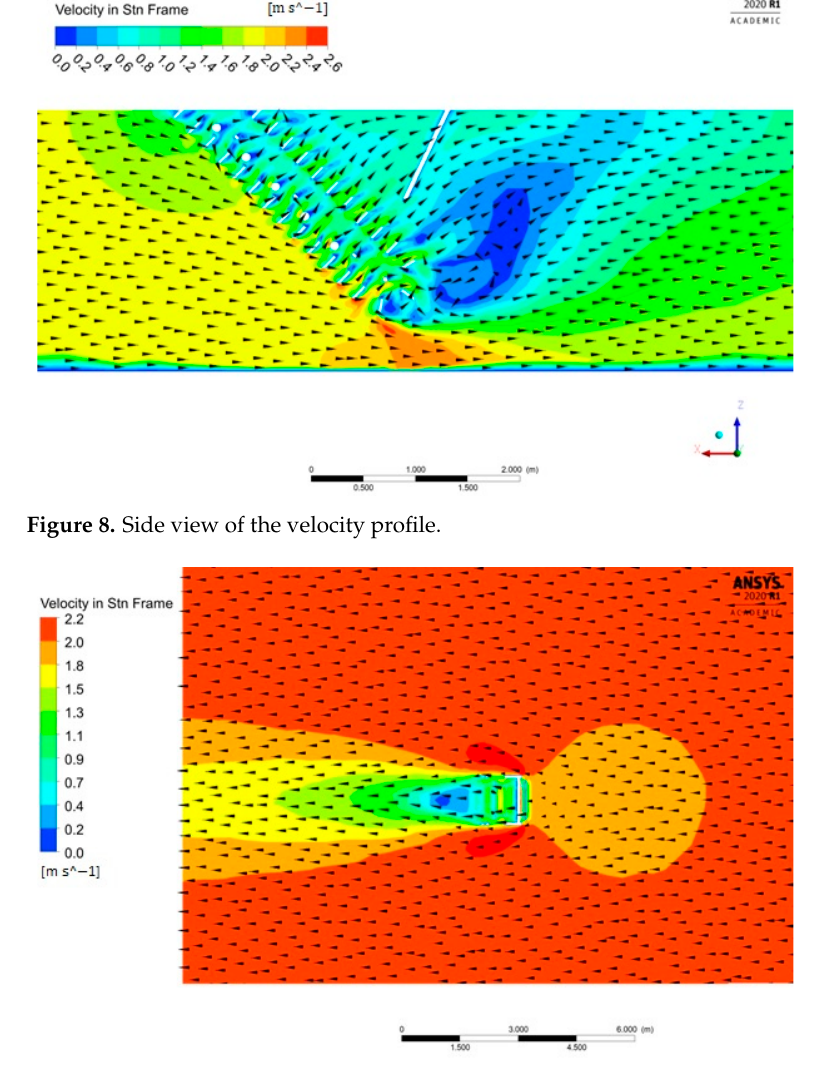
Figure 9. Top view of the velocity profile, 1 m under the top surface.